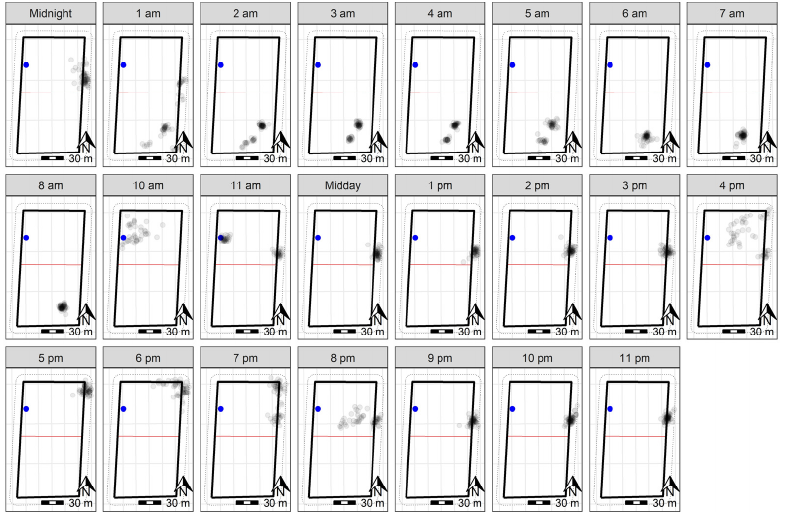
scale is included to indicate paddock size.